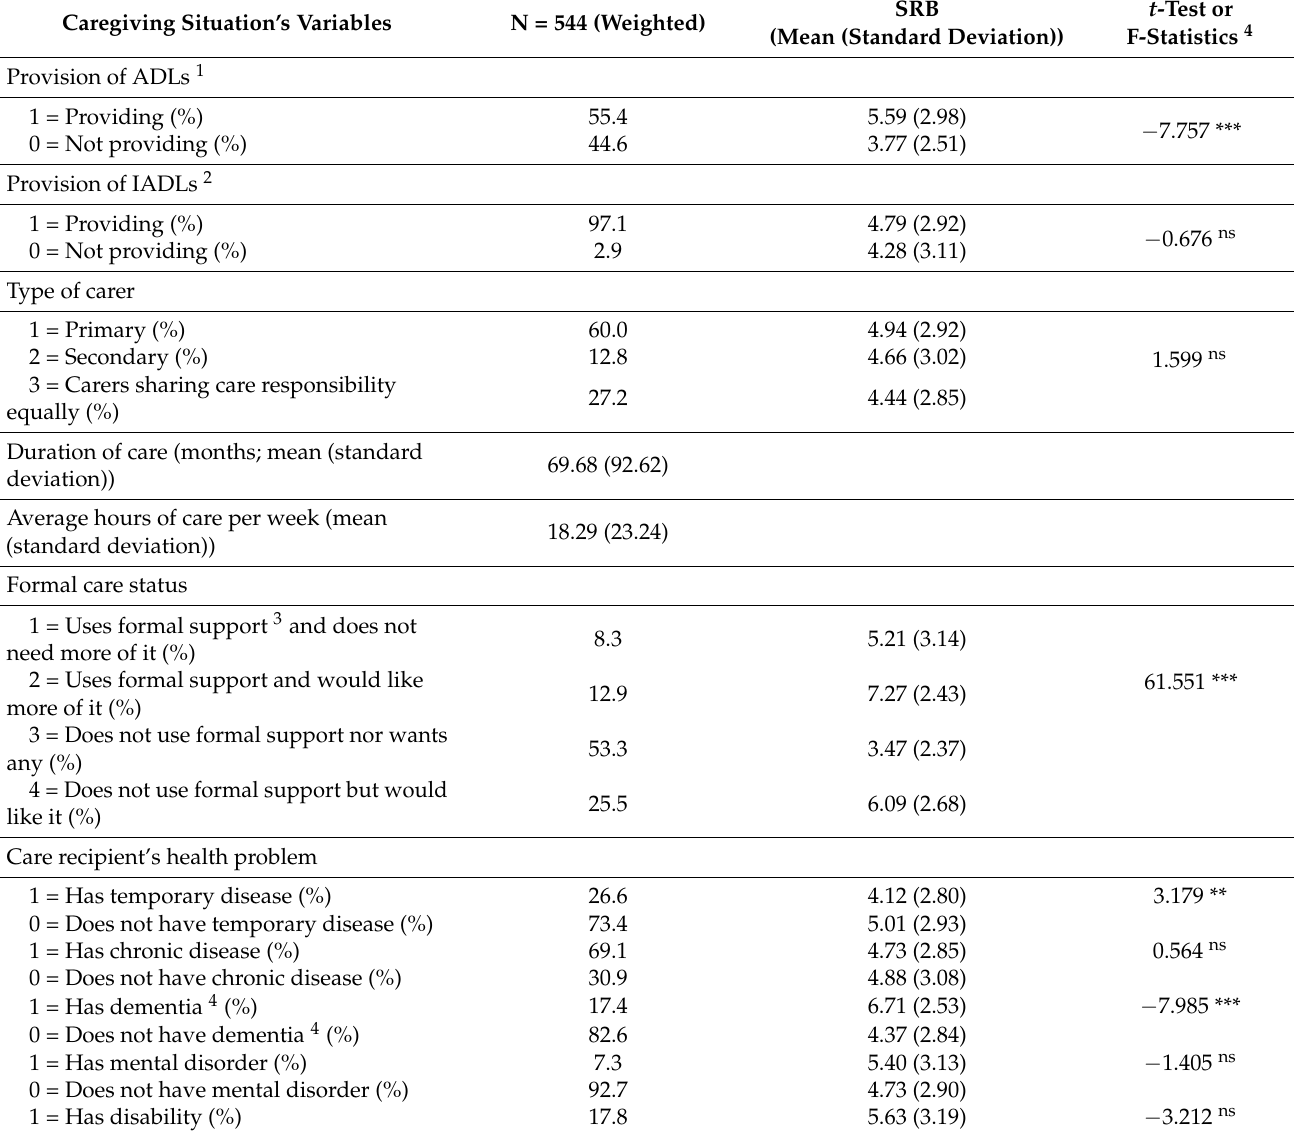
Table 2. Caregiving situation and self-rated care